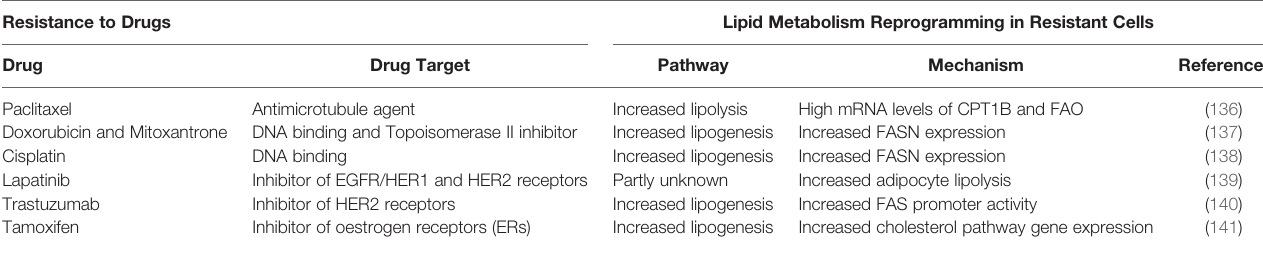
TABLE 3 | The most frequently used drugs in breast cancer treatment and the possible lipid metabolism pathway associated with resistance to different drugs. Resistance to